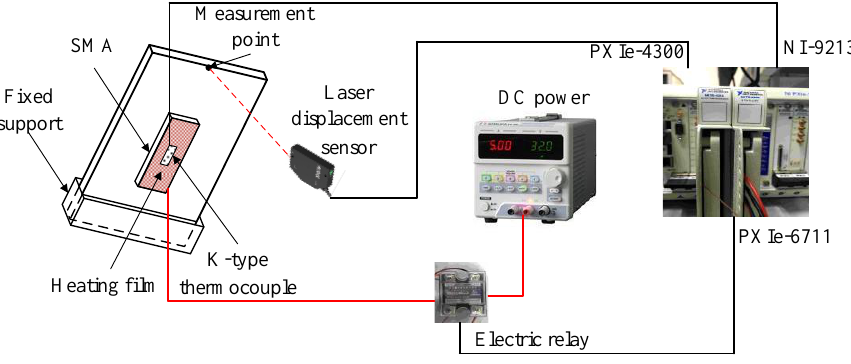
Figure 15. Experimental apparatus.